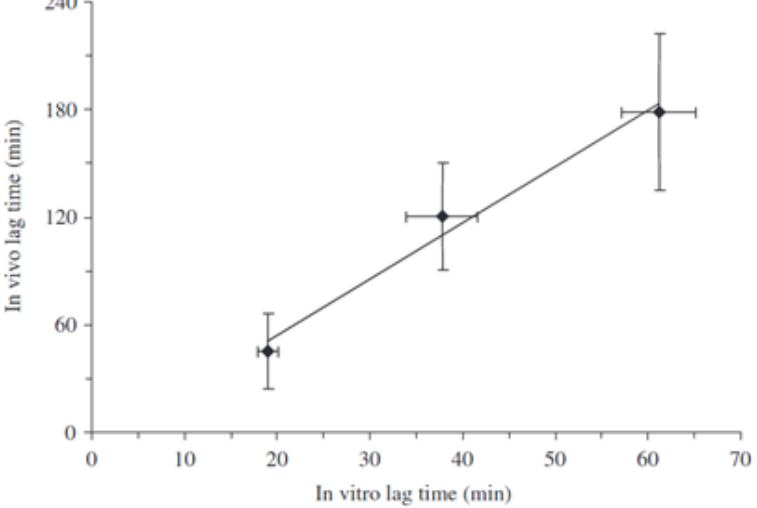
Figure 25. Relationship between in vitro t 10% (time to 10% release) and in vivo t 10% (time to 10% C max ) for hard-gelatin capsule-based systems coated with Methocel ® E50 to increasing HPMC layer thicknesses. Reprinted with permission from Ref. [58]. 2009, John Wiley & Sons.